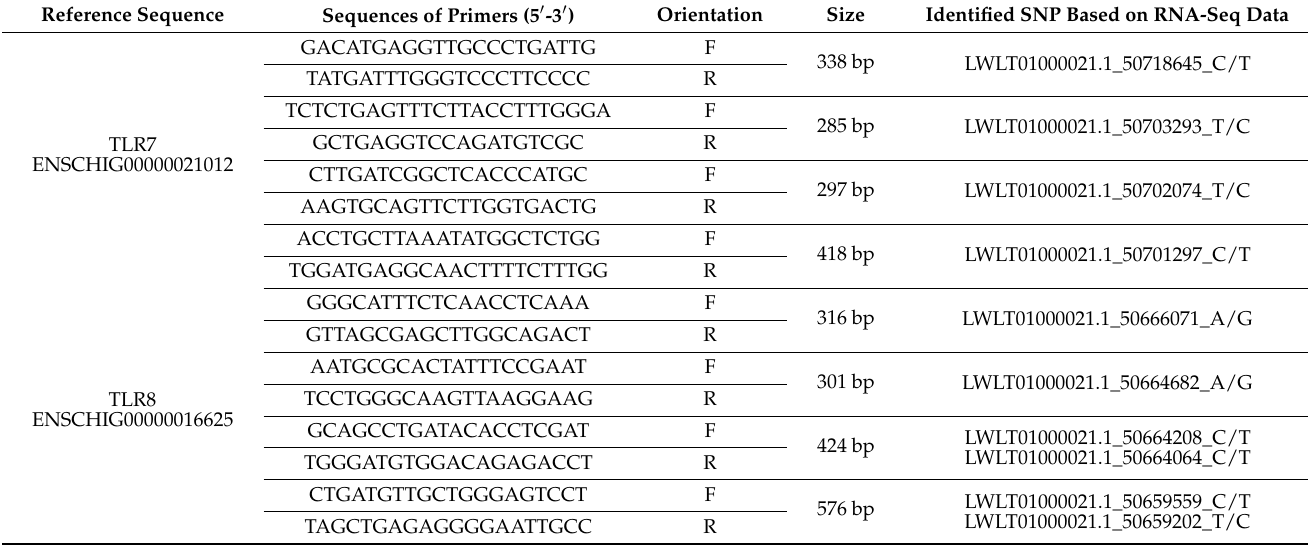
Table 1. Primers used for amplification of TLR7 and TLR8